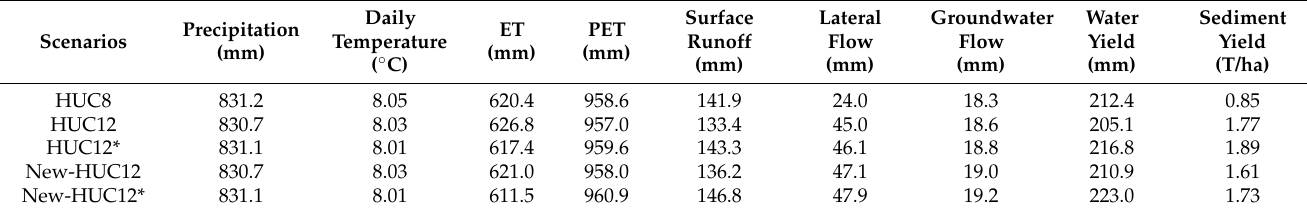
Table 7. Average annual values of hydrologic components (mm) and daily mean temperature ( ◦ C) over the UMRB in different scenarios during 1983 to 2005.